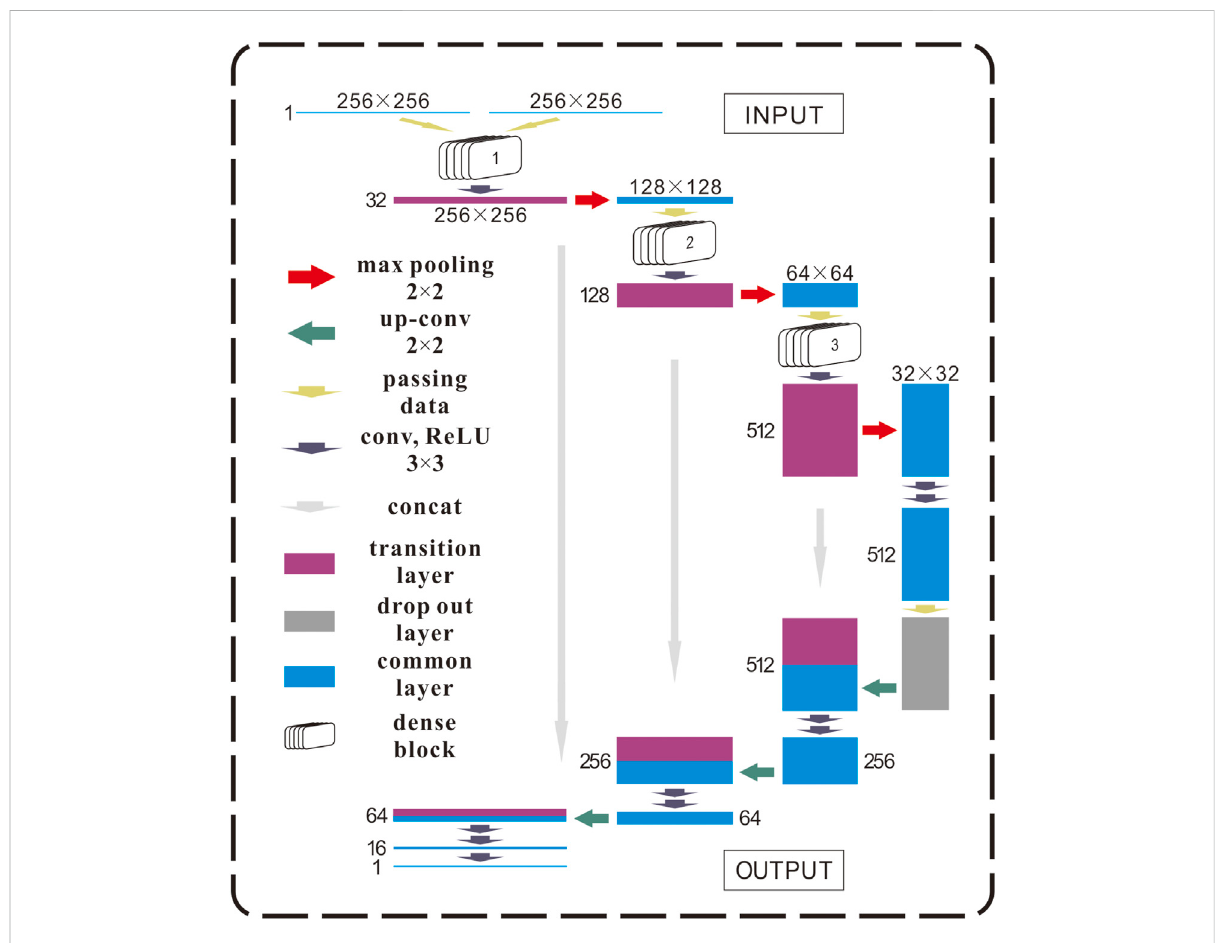
FIGURE 2 Logical diagram of the D-Unet network